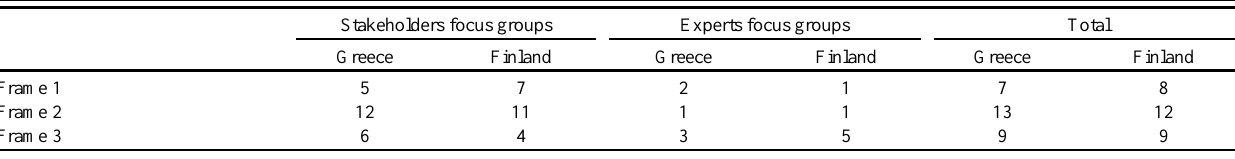
Table 3 . The number of research participants that can be attributed to each frame. Frame 1 refers to framing scale challenges as derived from scientific knowledge gaps, Frame 2 refers to framing scale challenges as derived from limited fit, and Frame 3 refers to framing scale challenges as derived from existing power relationships and learning